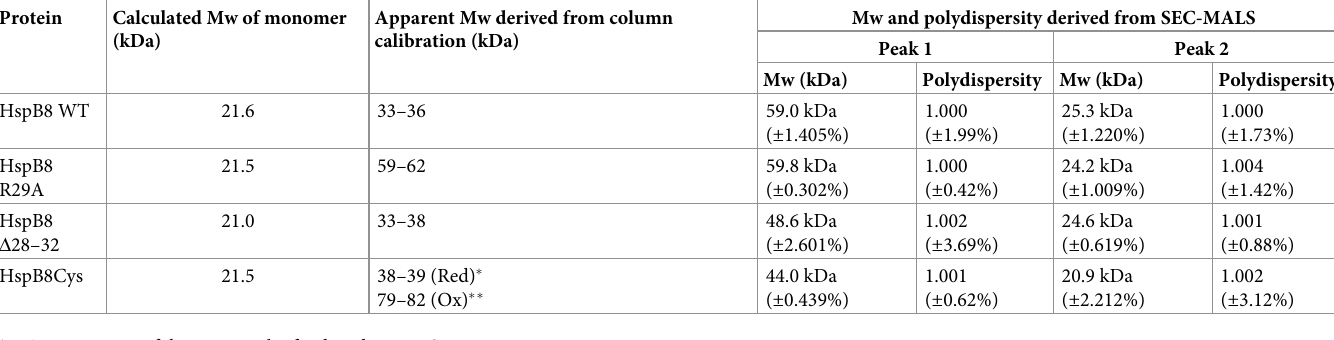
Mw and polydispersity derived from